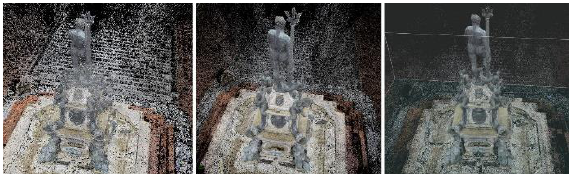
Figure 2: The sparse point cloud (PS, Pix4D, ReCap, respectively) derived after the BA. DATASET 5 – Neptune temple (857 images) PS